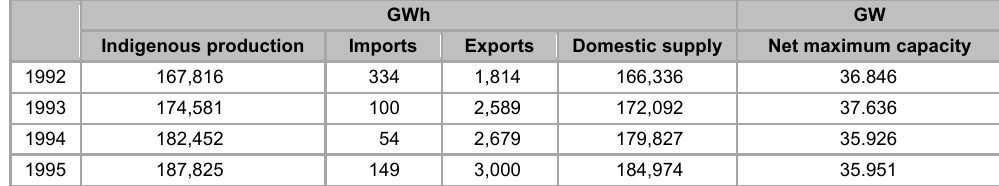
Selected electricity supply statistics in South Africa: 1992 to 2006 GWh GW Indigenous production Imports Exports Domestic